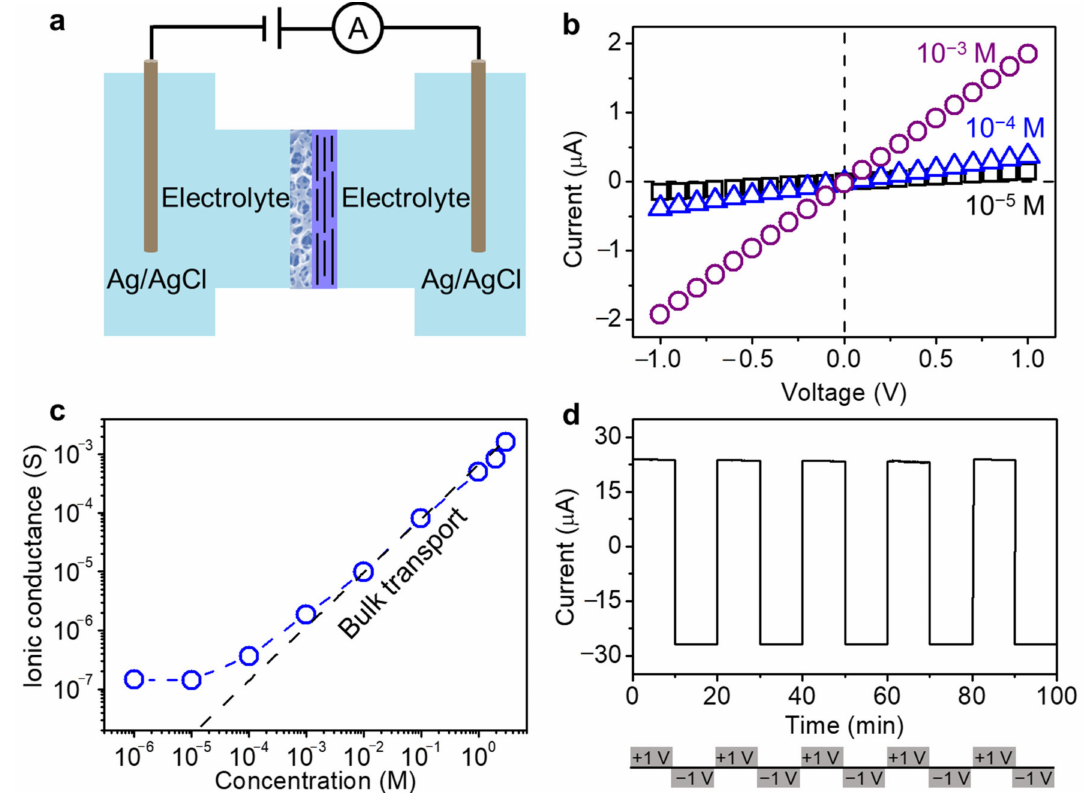
Figure 3. Charge-governed ion transport through the GO–CA heterogeneous membrane: ( a ) ionic transport measurement through GOM; ( b ) I–V characteristics of the GO–CA heterogeneous membrane for varying KCl concentrations; ( c ) ionic conductance of GO–CA heterogeneous membrane as a function of KCl concentration, which deviates from bulk value (dashed line) at 10 − 2 M, indicating the charge-governed ion transport; ( d ) time-dependent current of GO–CA heterogeneous membrane recorded in 0.1 M KCl with an external bias alternating between +1 and − 1 V (20 min per cycle), showing excellent